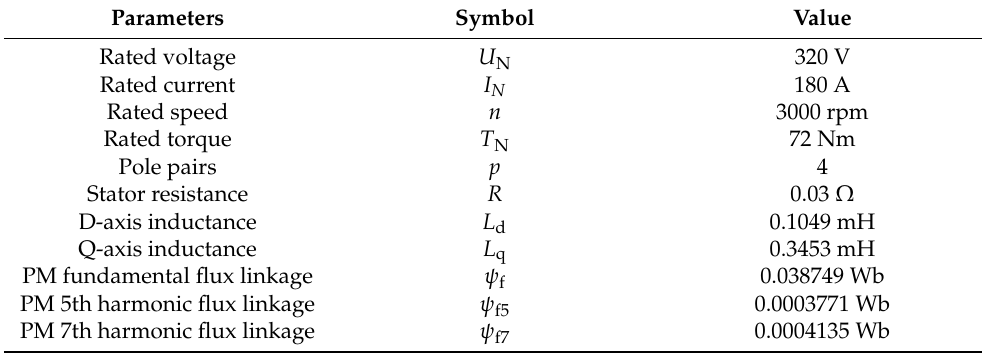
Table 1. The parameters of IPMSM.